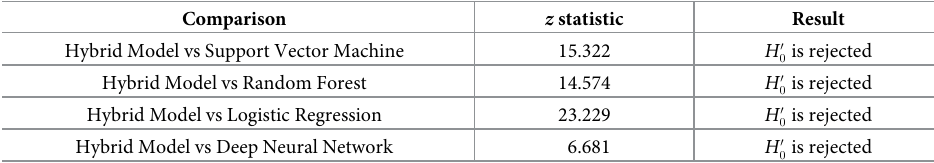
Table 7. Post-hoc test using the hybrid model as the control